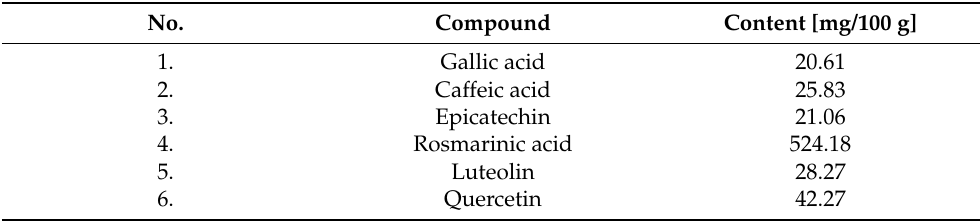
Table 5. Content of major polyphenols (phenolic acids and flavonoids) in wild thyme extract obtained under optimal